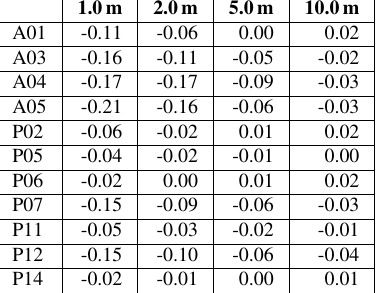
Table 3. Mean deviations [m] of different digital water surface models from the reference water level for the 99%